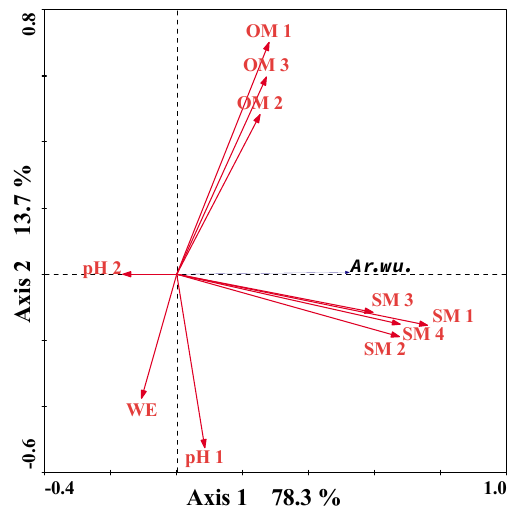
Figure 3. Redundancy analysis (RDA) of the relationship between sexual reproduction of A. wudanica (i.e. seedling density) and the field and environmental factors. The amount of variability explained by all the canonical axes was 92% ( F = 3.520, p = 0.0100). Abbre- viations for the study variables are given in Table 1.